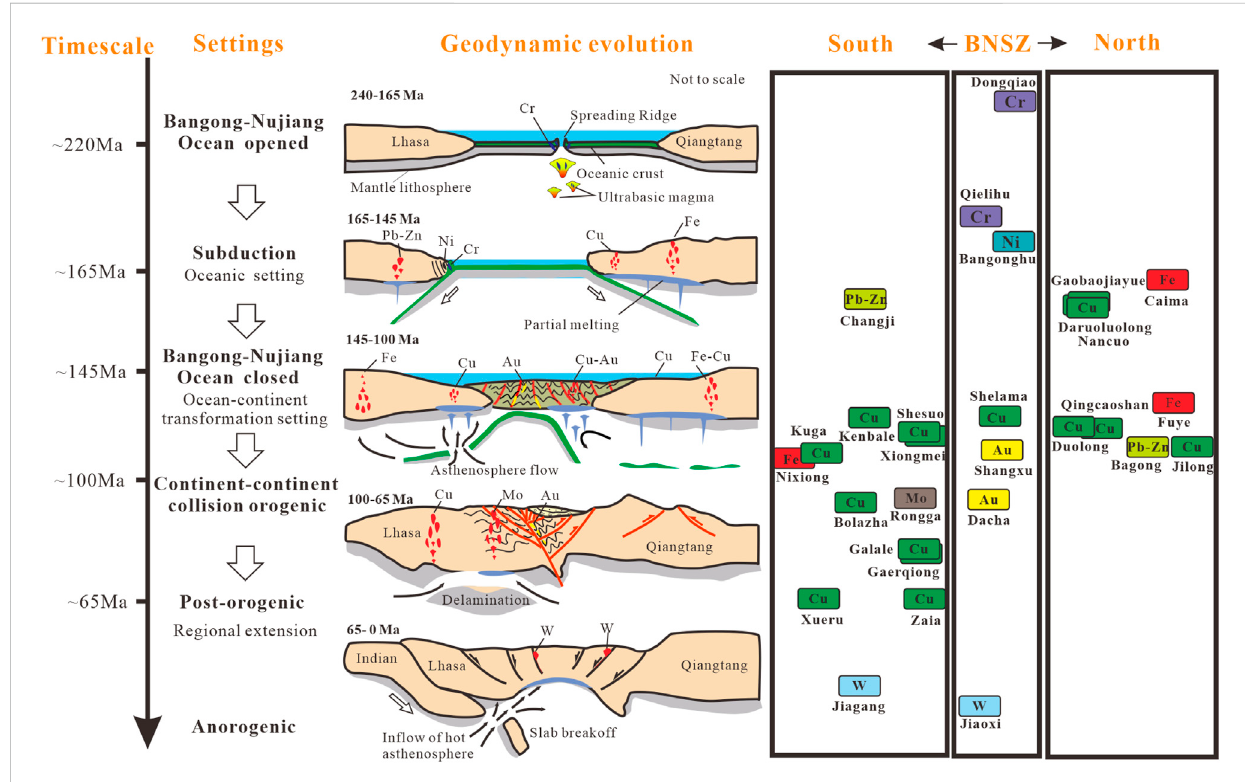
FIGURE 9 Geodynamic evolution and mineralization of the Bangong – Nujiang metallogenic